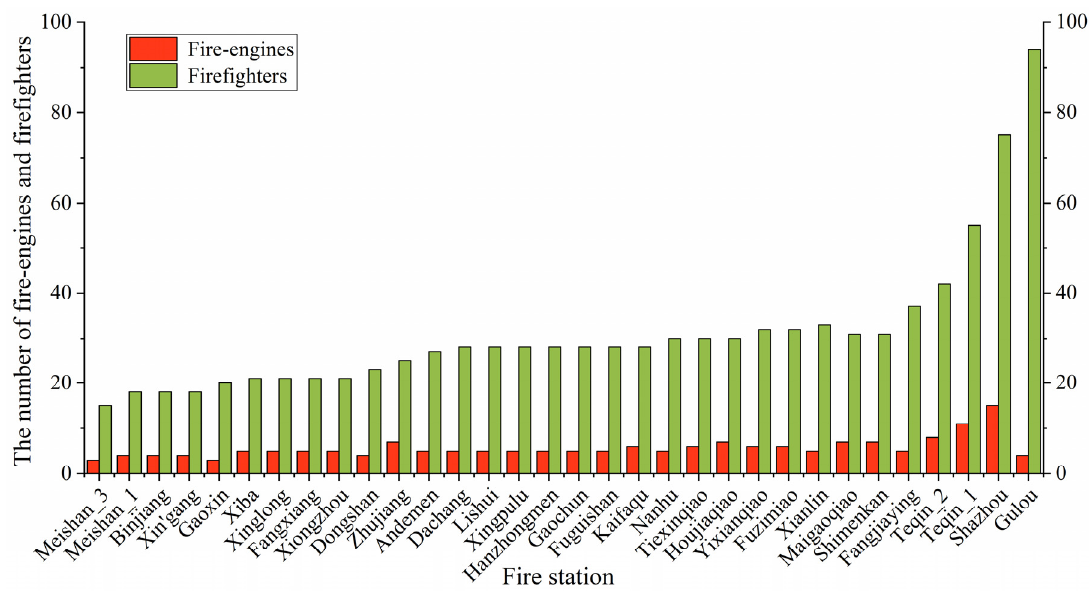
Figure 2. Histogram of the firefighters and fire engines in each fire station.